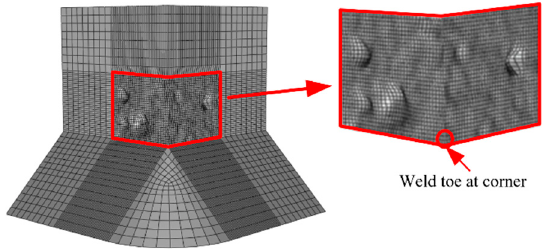
Figure 6. Corrosion morphology included in a